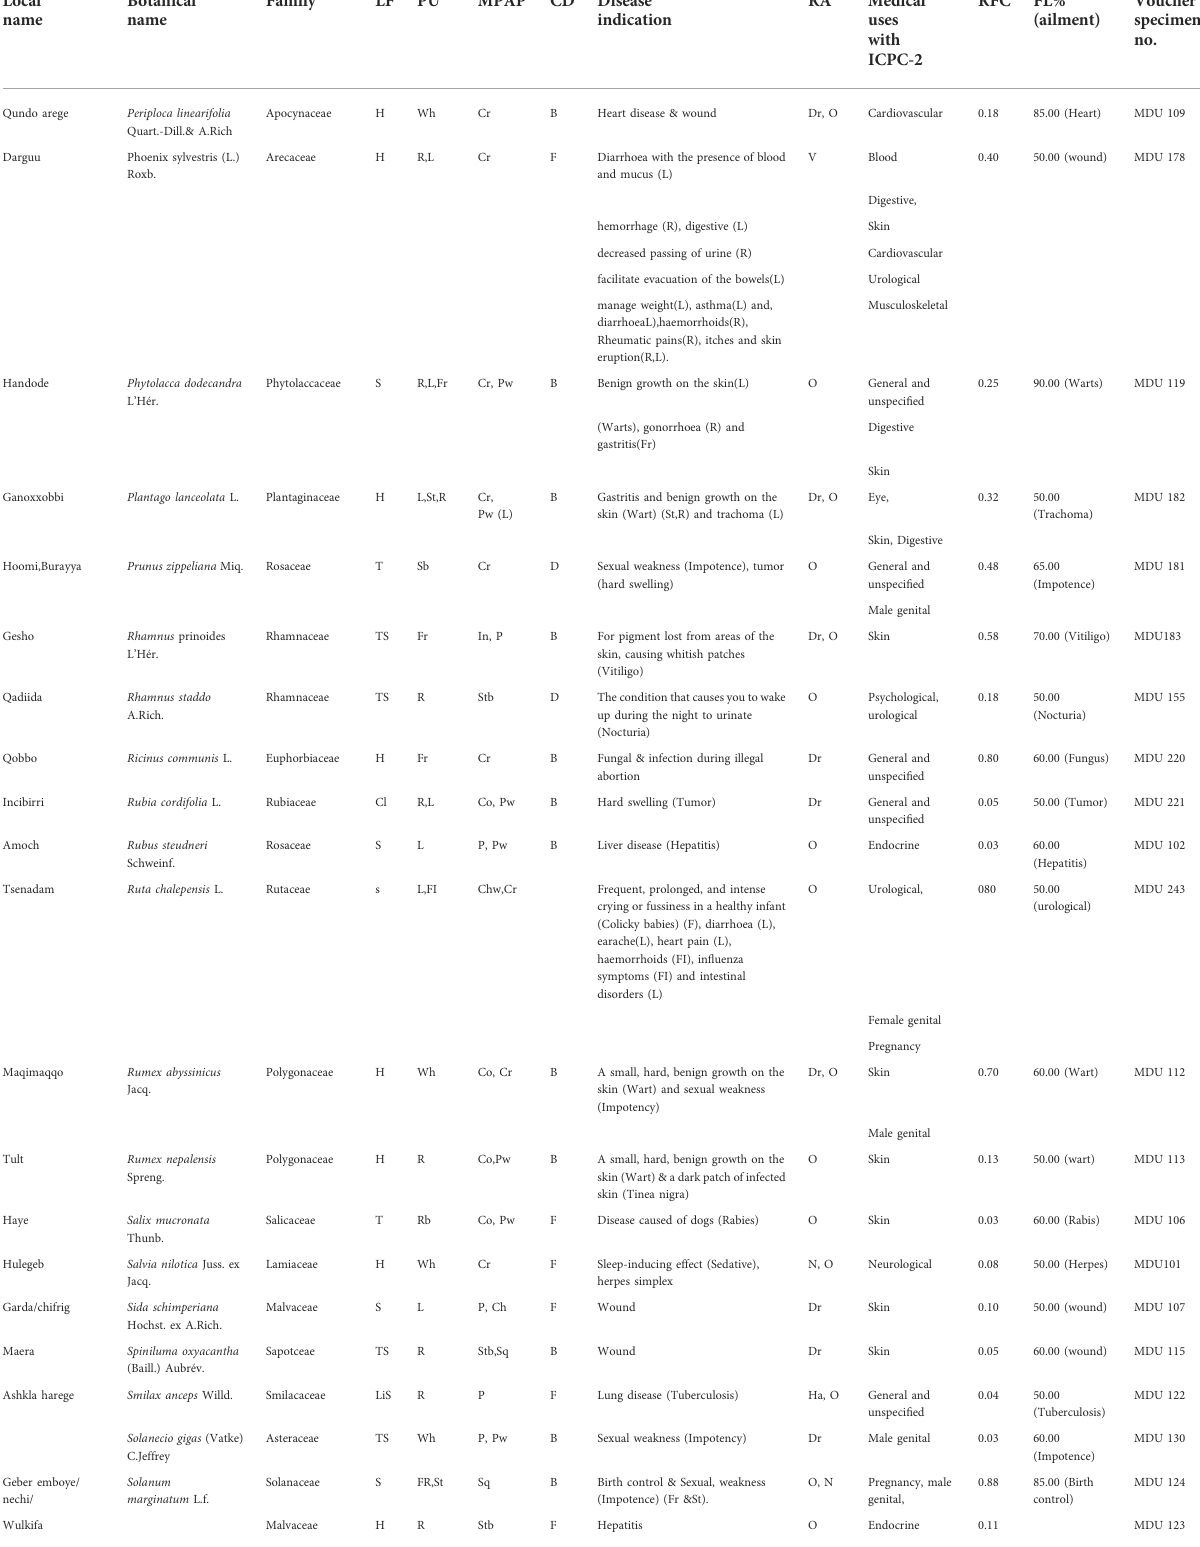
Geber emboye/ nechi/